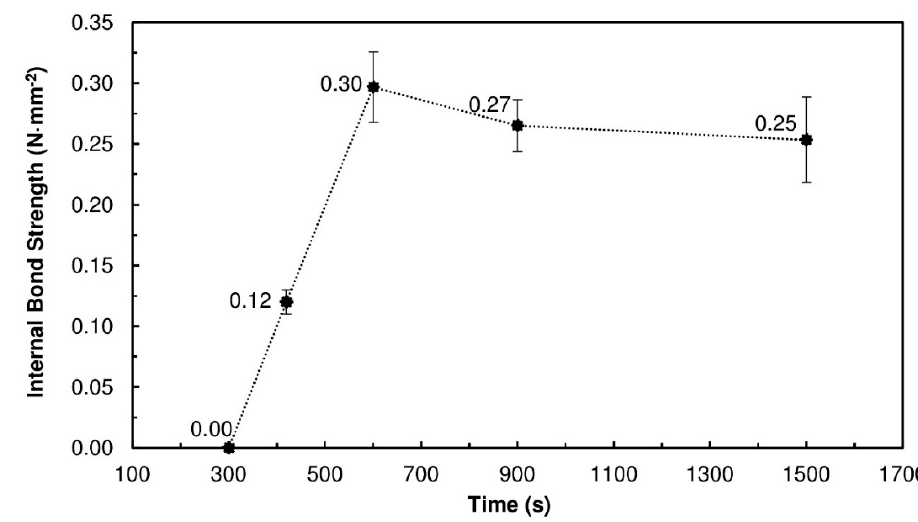
Figure 2. IB strength of the PBs produced with 20% TSSL at different pressing times (300 s, 420 s, 600 s, 900 s, and 1500 s); the PBs were pressed at 190 °C.